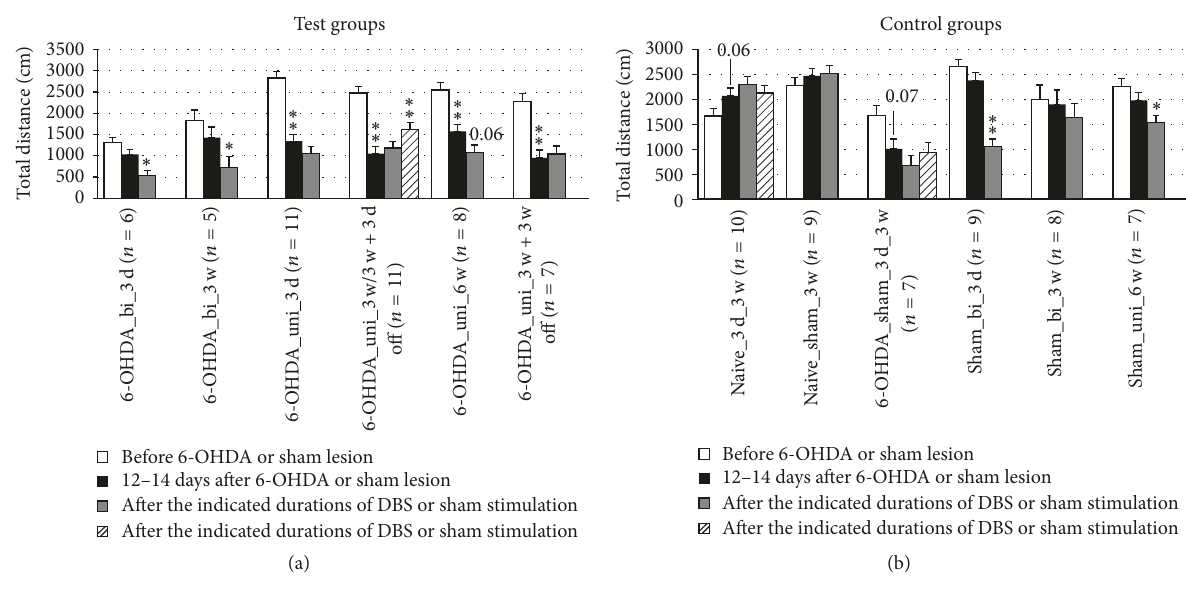
Figure 11: Short-term and long-term effects of DBS with uni- and bipolar electrodes on the locomotor activity of hemiparkinsonian rats as measured by the total migration distance in the open field. (a) and (b) refer to test groups and controls, respectively. Different column patterns indicate different times of behavioral testing; white: before 6-OHDA or sham lesion; black: 12–14 days after 6-OHDA or sham lesion; gray and hatched: after the durations of DBS or sham stimulation indicated in the group labels. For experimental details see Table 1. Significance levels are indicated with asterisks as follows: ∗∗ 𝑝 ≤ 0.01 , ∗ 𝑝 ≤ 0.05 , b (borderline): 0.05 < 𝑝 ≤ 0.08 according to one-way ANOVA. Asterisks above black columns refer to white columns; all others refer to black